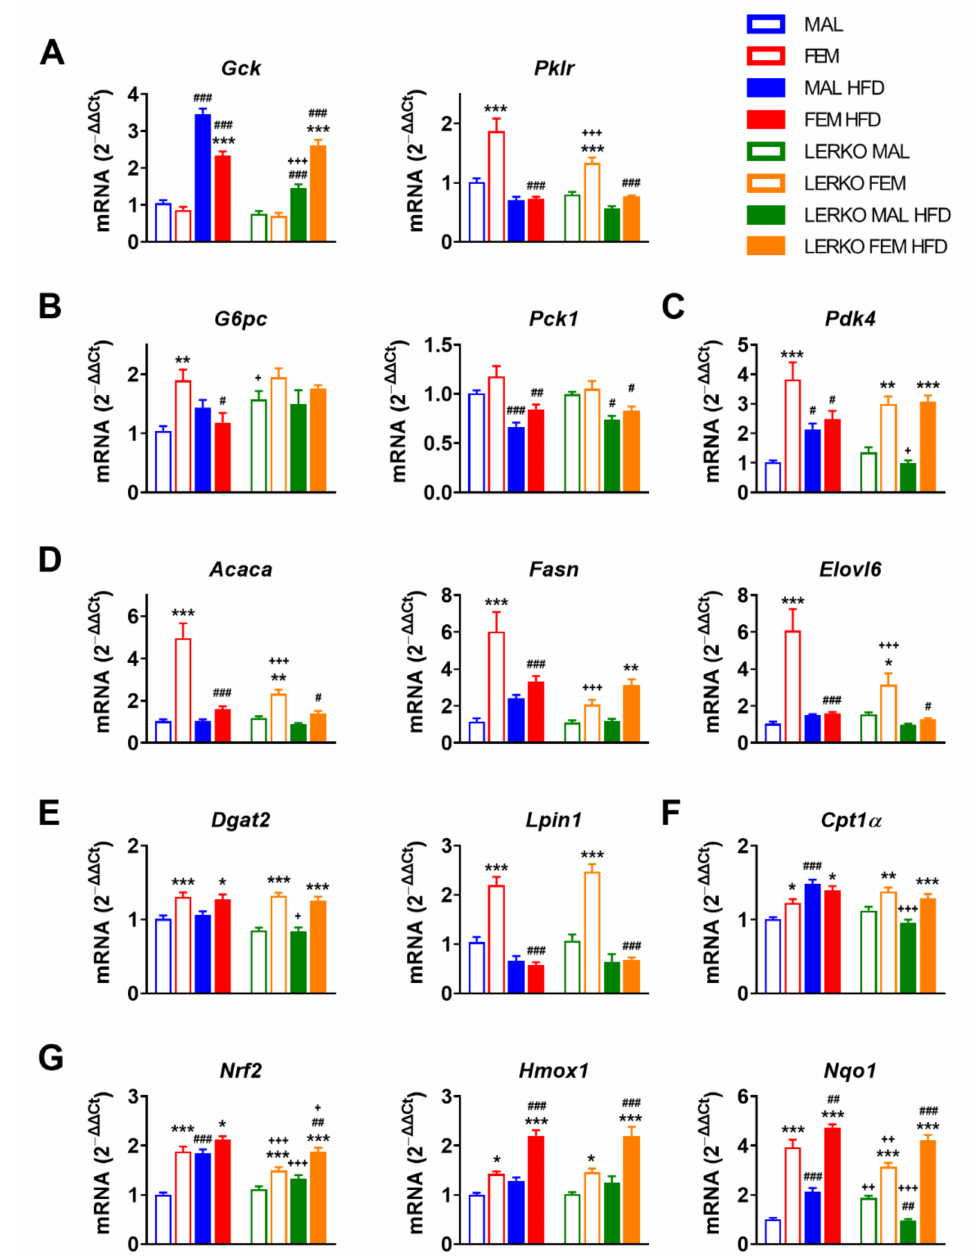
Figure 5. Sex-specific metabolic adaptation to HFD depends on hepatic ER α . ( A – G ) mRNA contents of key genes involved in glycolysis ( A ), gluconeogenesis ( B ), regulation of glucose metabolism ( C ), fatty acid synthesis and elongation ( D ), triglyceride synthesis ( E ), fatty acid catabolism ( F ), and oxidative stress response ( G ) measured by RT-PCR in the liver of male and female control and LERKO mice fed with control or HFD. Data are presented as mean ± SEM ( n = 8–10). * p < 0.05, ** p < 0.01 and *** p < 0.001 females vs. males; # p < 0.05, ## p < 0.01 and ### p < 0.001 HFD vs. control diet; + p < 0.05, ++ p < 0.01 and +++ p < 0.001 LERKO vs. control mice by two-way ANOVA followed